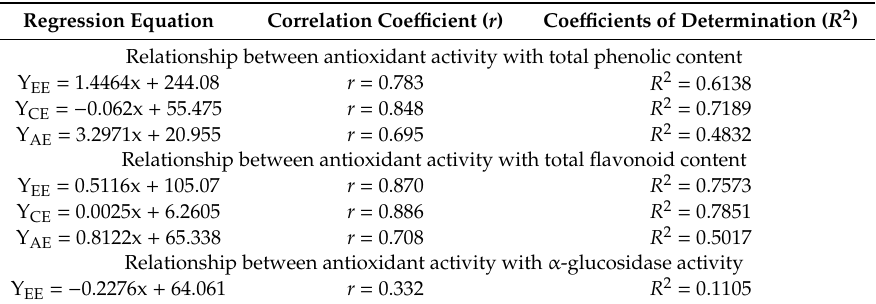
Table 4. Regression equation, correlation coefficient (r) and coefficients of determination (R 2 ) of antioxidant activity with total phenol, total flavonoid and α-glucosidase activity. EE = Ethanol extract, CE = Chloroform extract and AE = Aqueous extract.